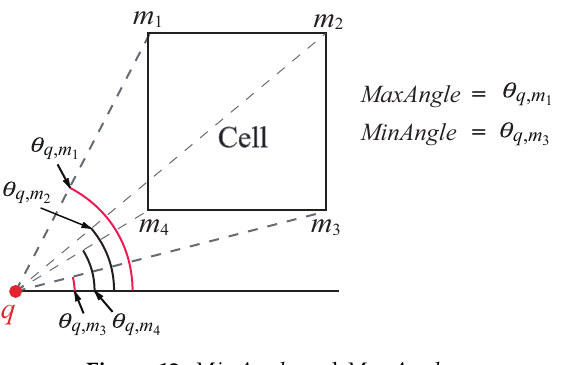
Figure 12. MinAngle and MaxAngle